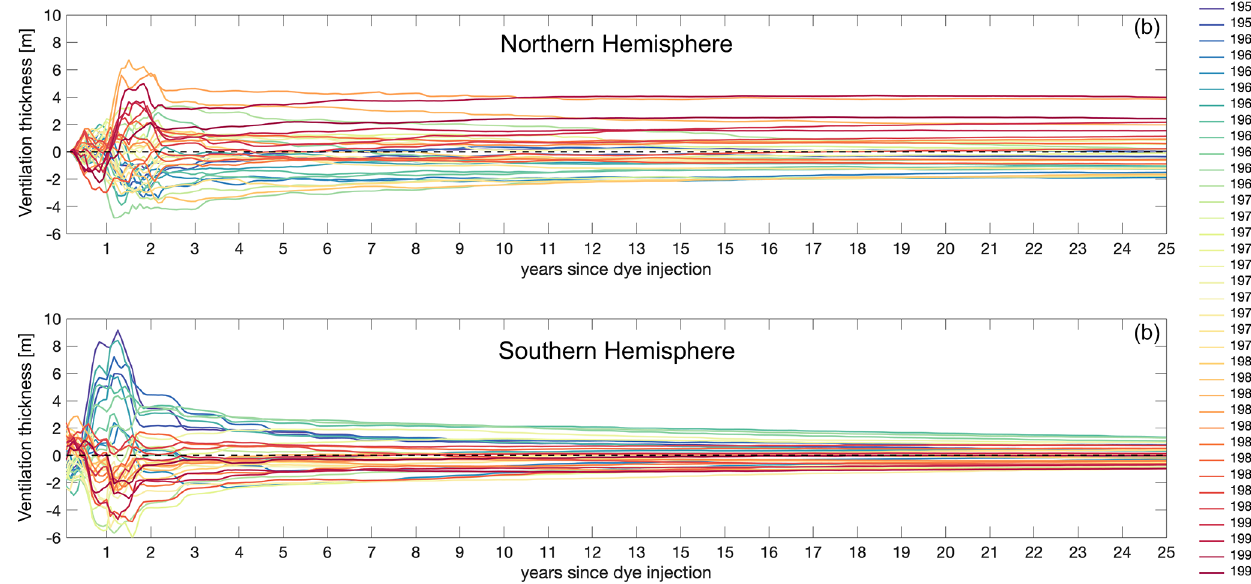
Figure 8. Ventilation thickness anomaly (from the 1958–1993 mean) for 36 of the 60 dyes (1958 to 1993 vintages) from injection to 25 years later.